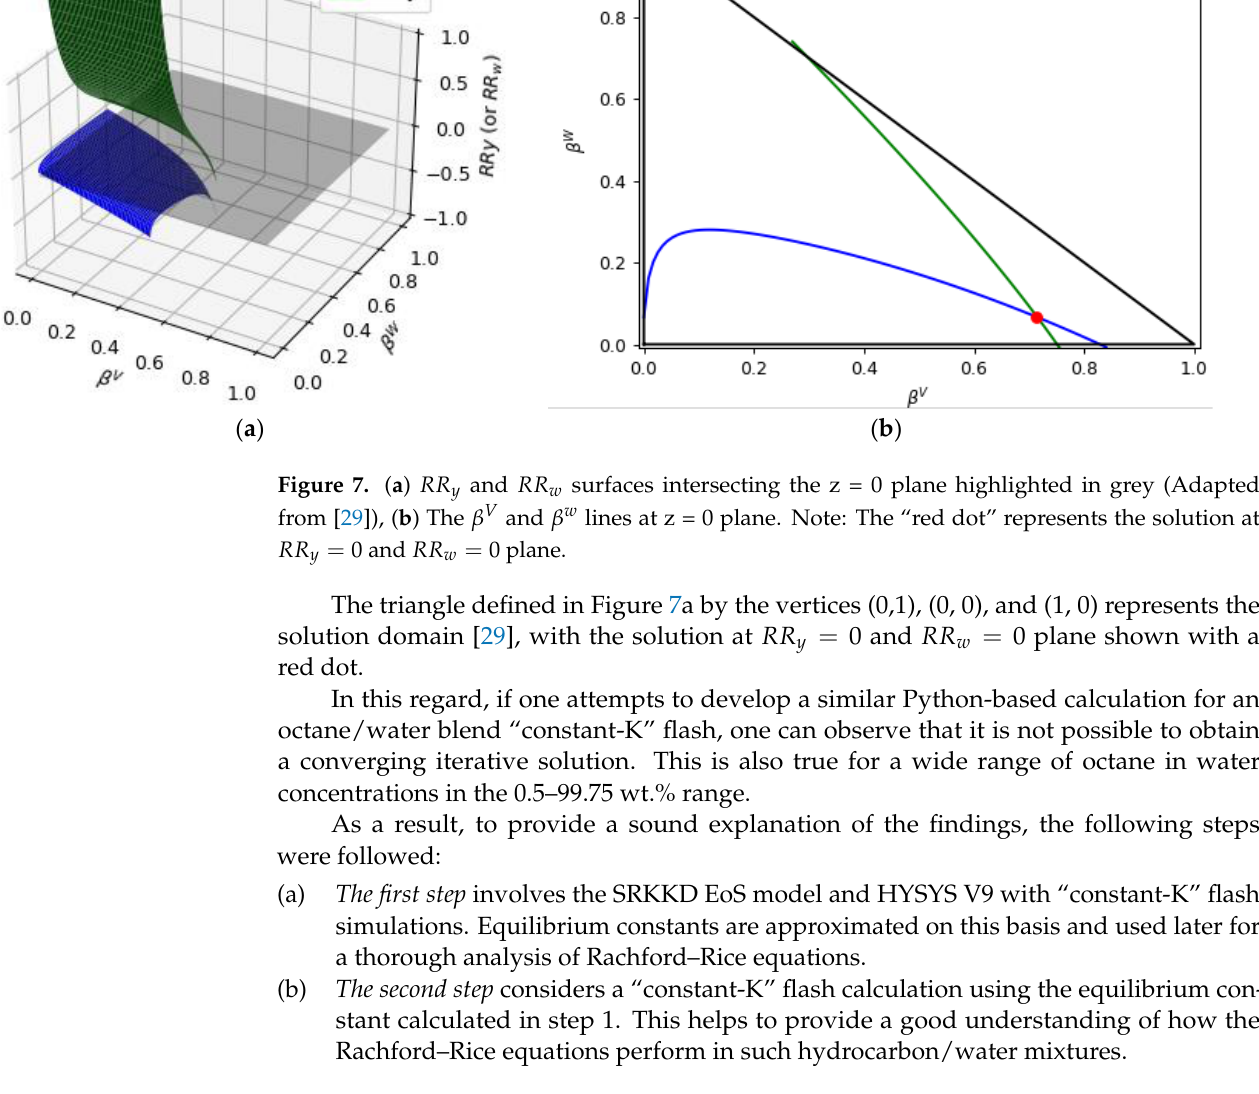
Table 4. HYSYS V9 results for three-phase flash calculations at T = 80 °C using SRKKD.